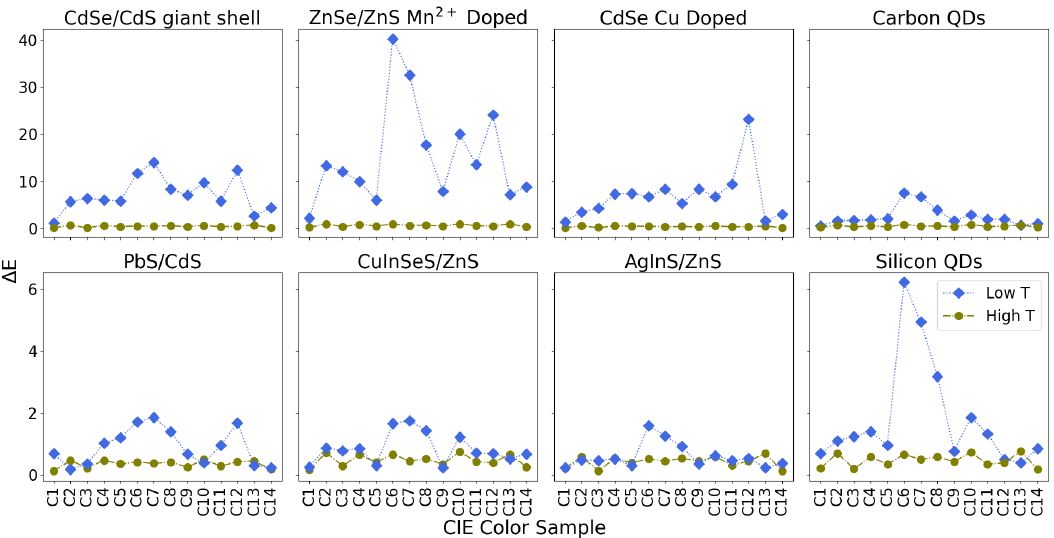
Figure 12. ∆ E for the 14 CIE color samples for high (T vis = 90%) and low (T vis = 50%) transmittance values.